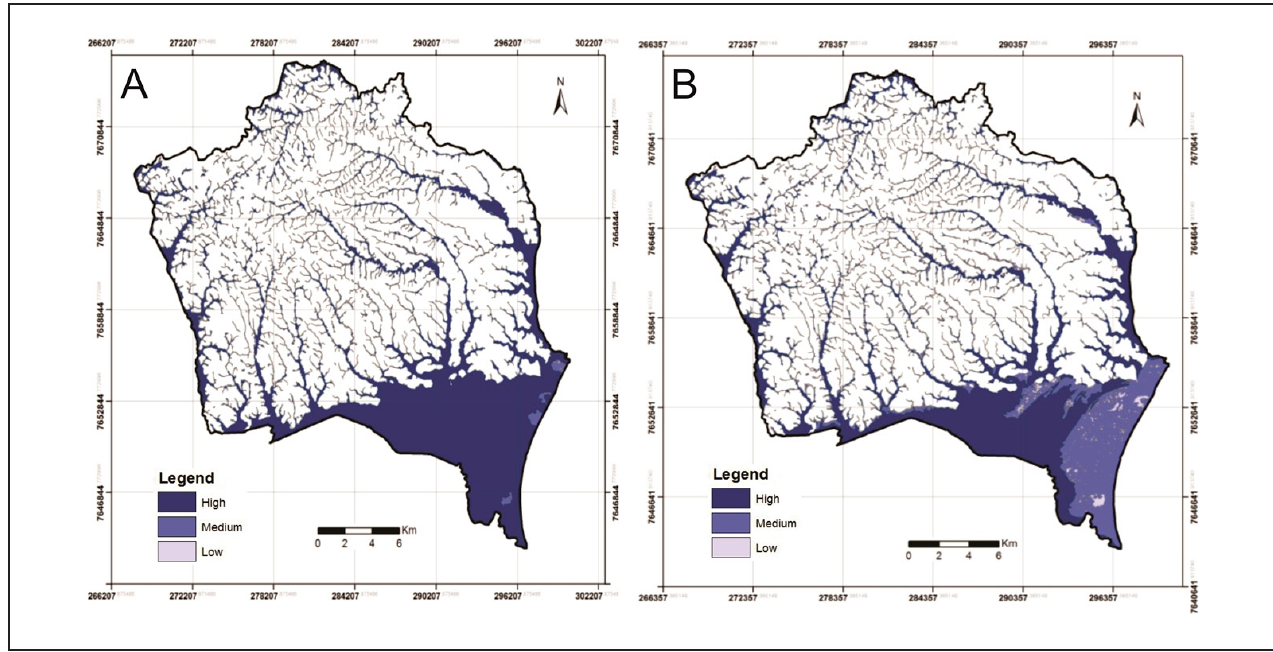
Figure 7 - Flood modeling of Presidente Kennedy, ES. (A) Modeling following the old methodology. (B) Flood modeling using the new methodology that replaces basin information with flood susceptibility of relief